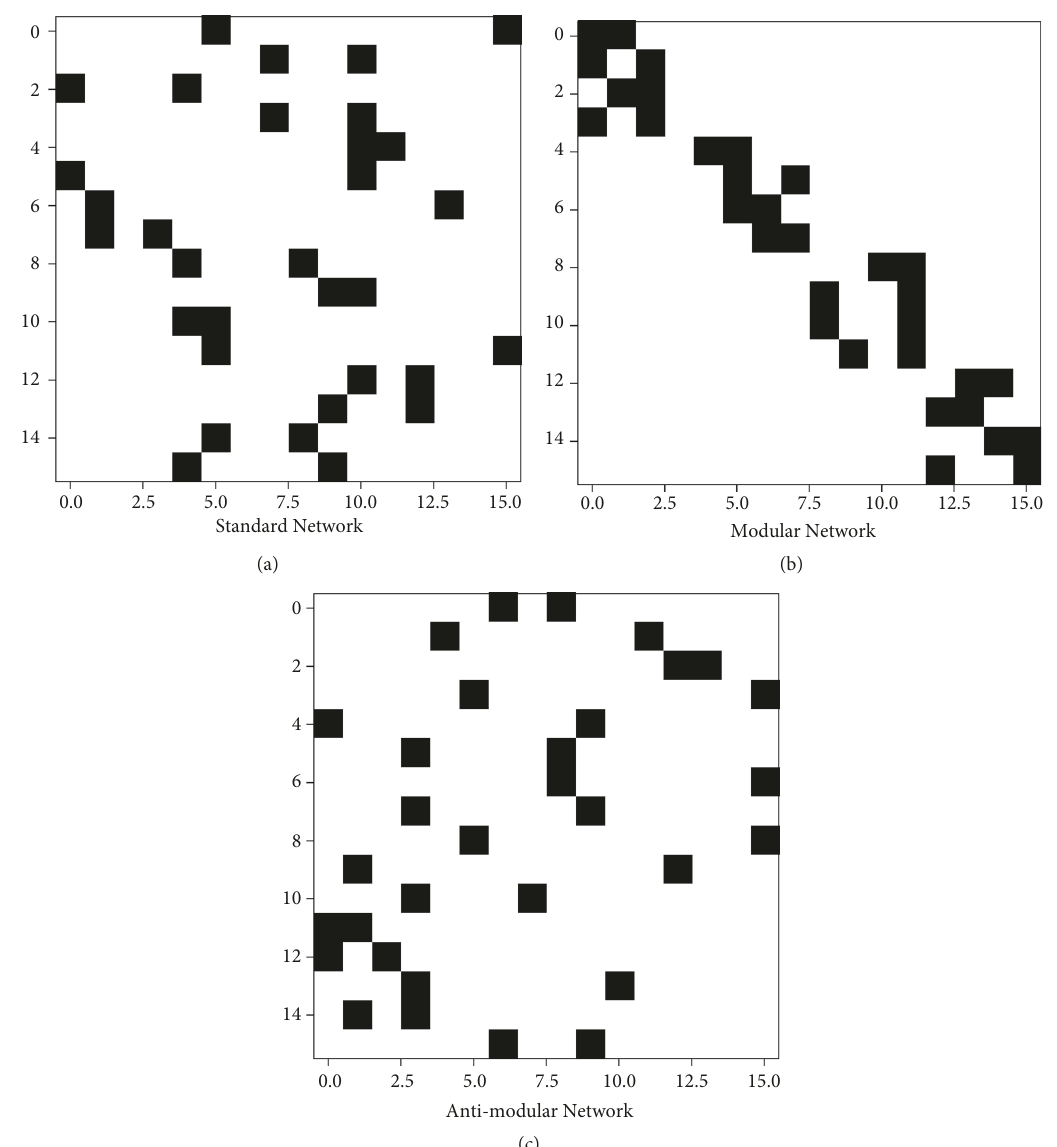
Figure 17: Adjacency matrixes of standard, modular, and antimodular RBN with N = 16, K =